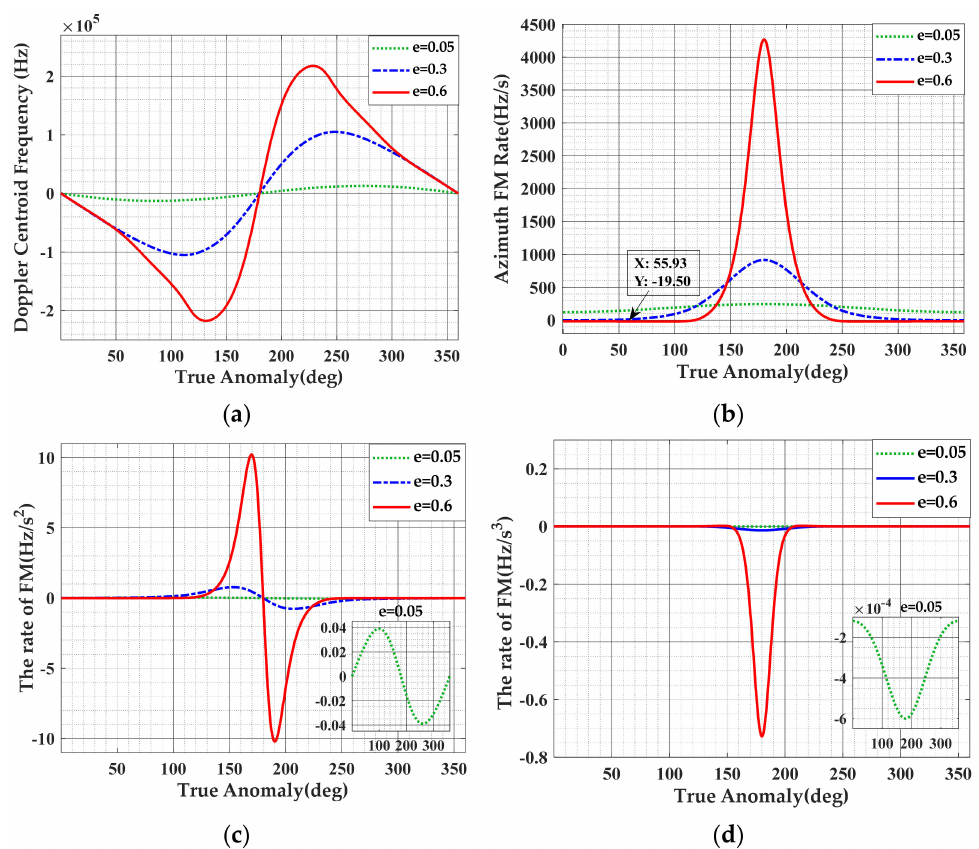
Figure 3. Analysis of Doppler Characteristics of HEO SAR. ( a ) Doppler center frequency. ( b ) Dop–pler frequency mod- ulation rate. ( c ) The rate of azimuth frequency modulation rate. ( d ) The second-order derivative of azimuth frequency modulation rate.